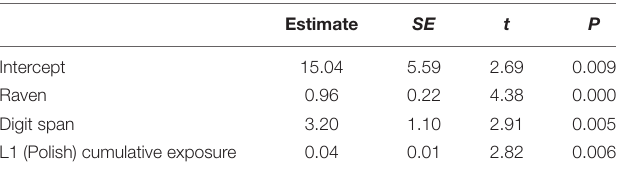
TABLE 2 | The best regression model predicting the receptive vocabulary in the bilingual group.